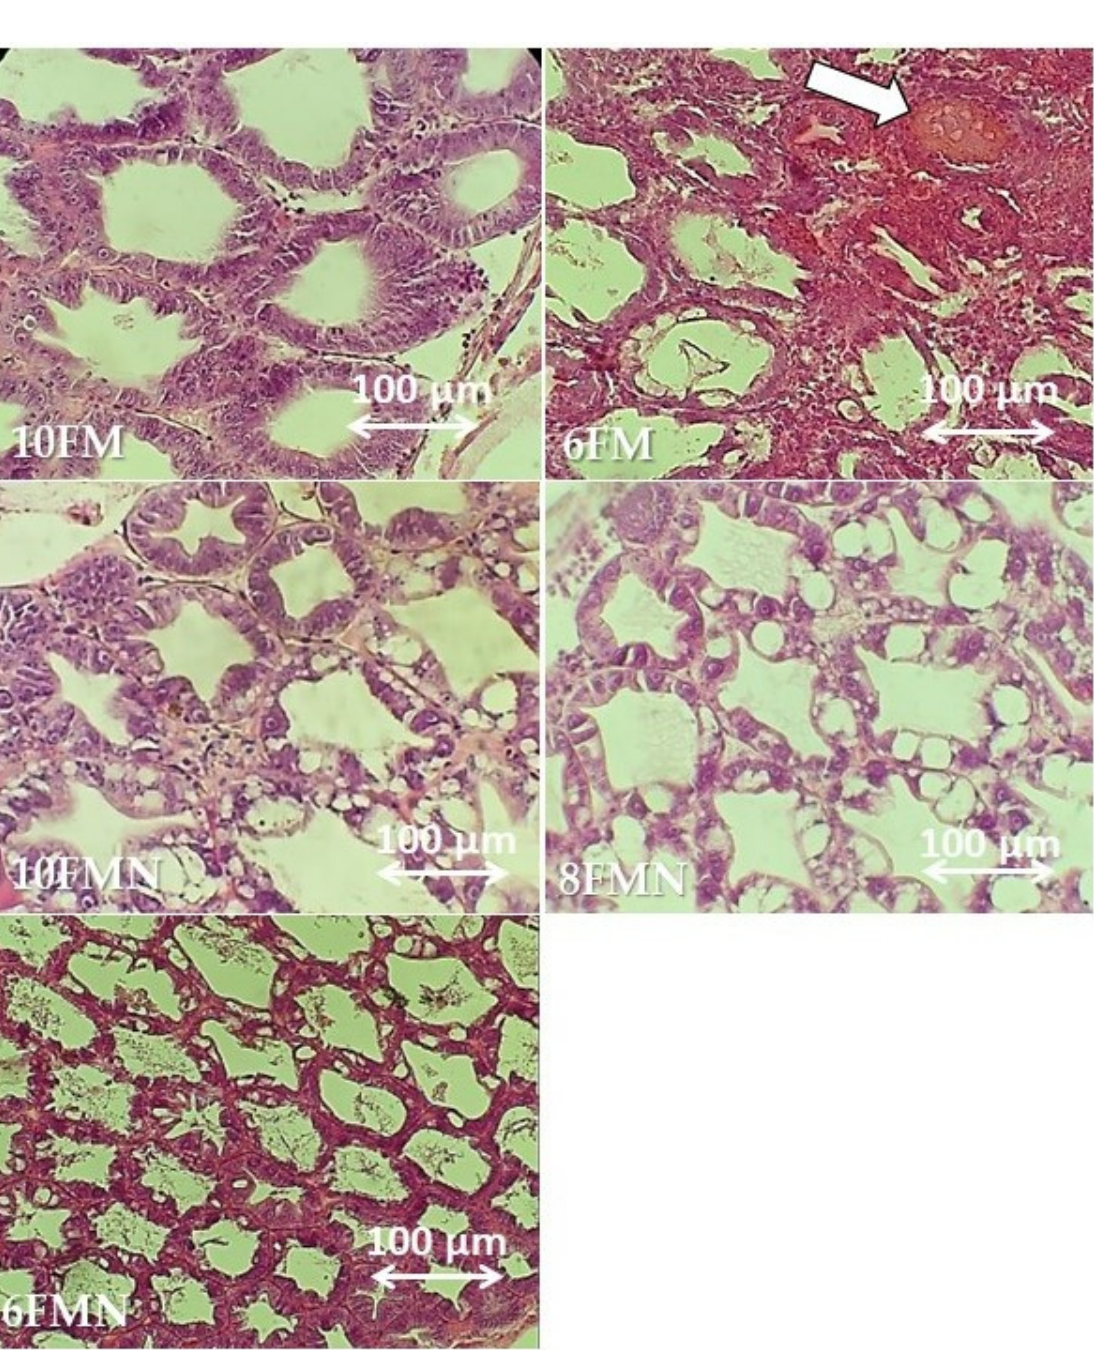
Figure 4. Representative histopathological images of hematoxylin and eosin-stained sections of the hepatopancreas from Pacific white shrimp (PWS) belonging to different study groups. 10FM (control group; 10% FM), 6FM (6% FM and no nucleotide supplementation), 10FMN (10% FM; 0.1% nucleotides), 8FMN (8% FM; 0.1% nucleotides) and 6FMN (6% FM; 0.1% nucleotides). The white arrow points to vacuolation observed in the 6FM group as a result of replacing fish meal with vegetable protein